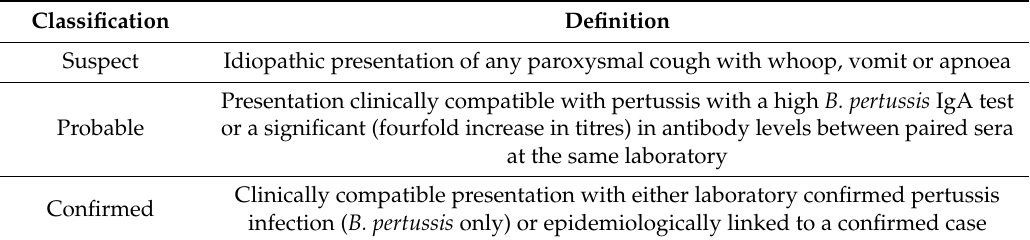
Table 2. Environmental Sciences and Research Limited Notification Classification System and criteria [46].